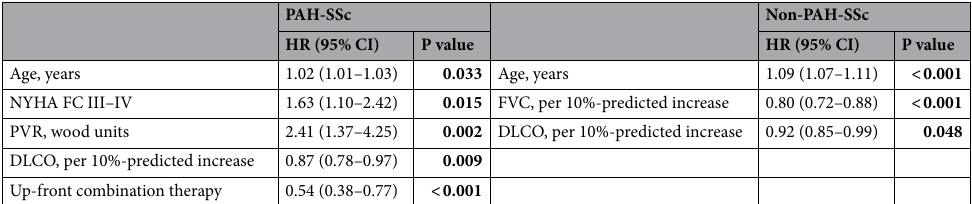
Table 4. Factors associated to survival in multivariate analyses. Significant values are in